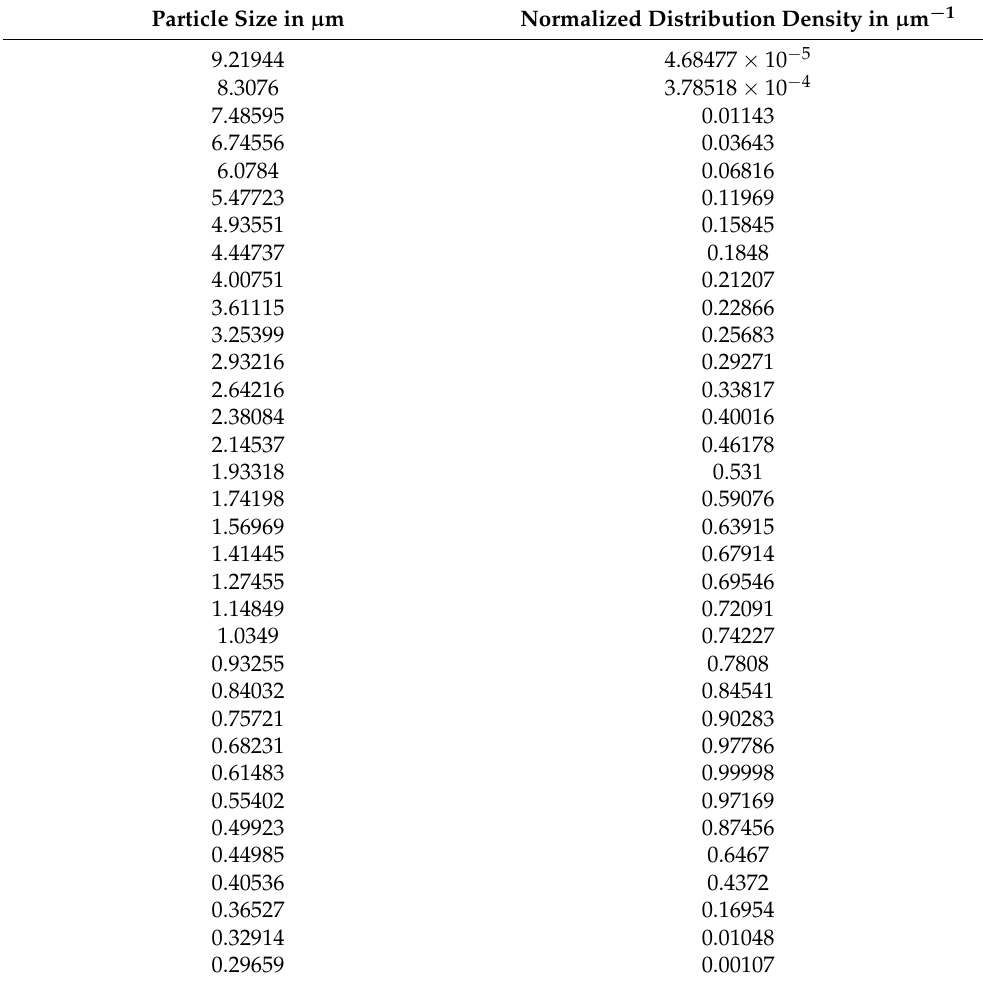
Table A14. Particle size distribution of a dispersion containing 10 m% graphite nanoparticles and 40 m% TX-100.